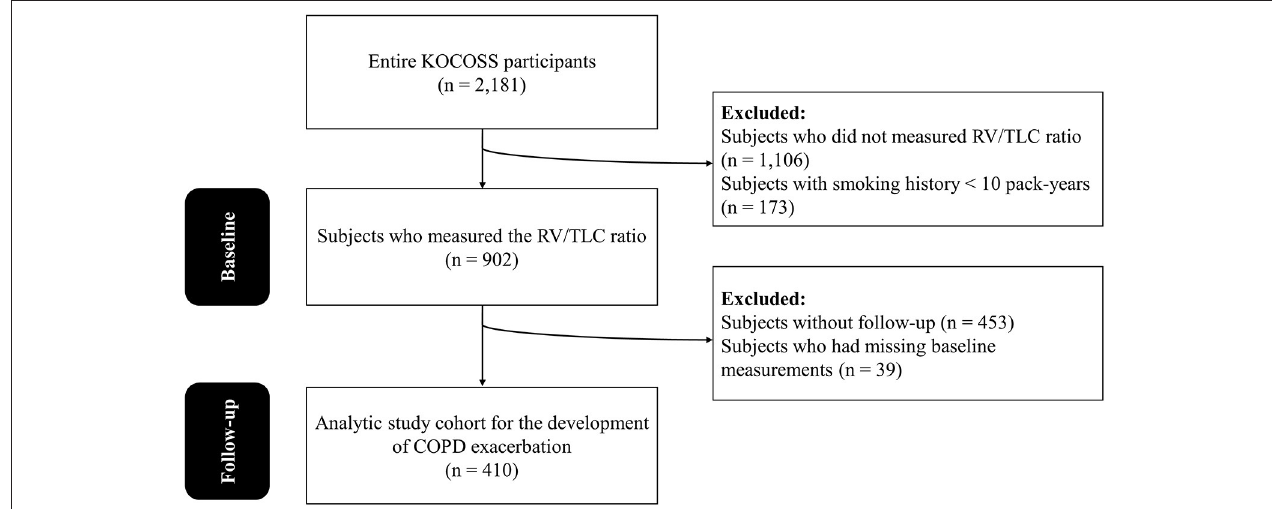
FIGURE 1 | The flow chart of the study participants. KOCOSS, the Korean COPD Subgroup Study; RV, residual volume; TLC, total lung capacity; COPD, chronic obstructive pulmonary disease.